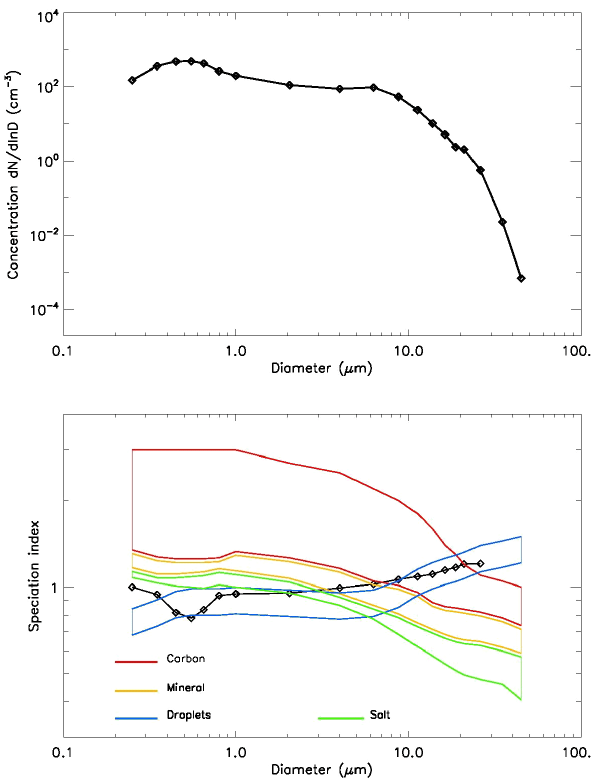
Figure 18. Example of the detection of salt particles above Mediter- ranean Sea (longitude of 40 ◦ 00 (cid:48) , latitude of 6 ◦ 40 (cid:48) , close to Minorca, Spain) from balloon on 22 July 2013 at 21:25UT at an altitude of 275 m during the ChArMEx campaign; upper panel: size distribu- tion; lower panel: typology, the LOAC data are in black dots. The LOAC uncertainties are ± 20% for the higher concentrations and ± 60% for the lower concentrations.